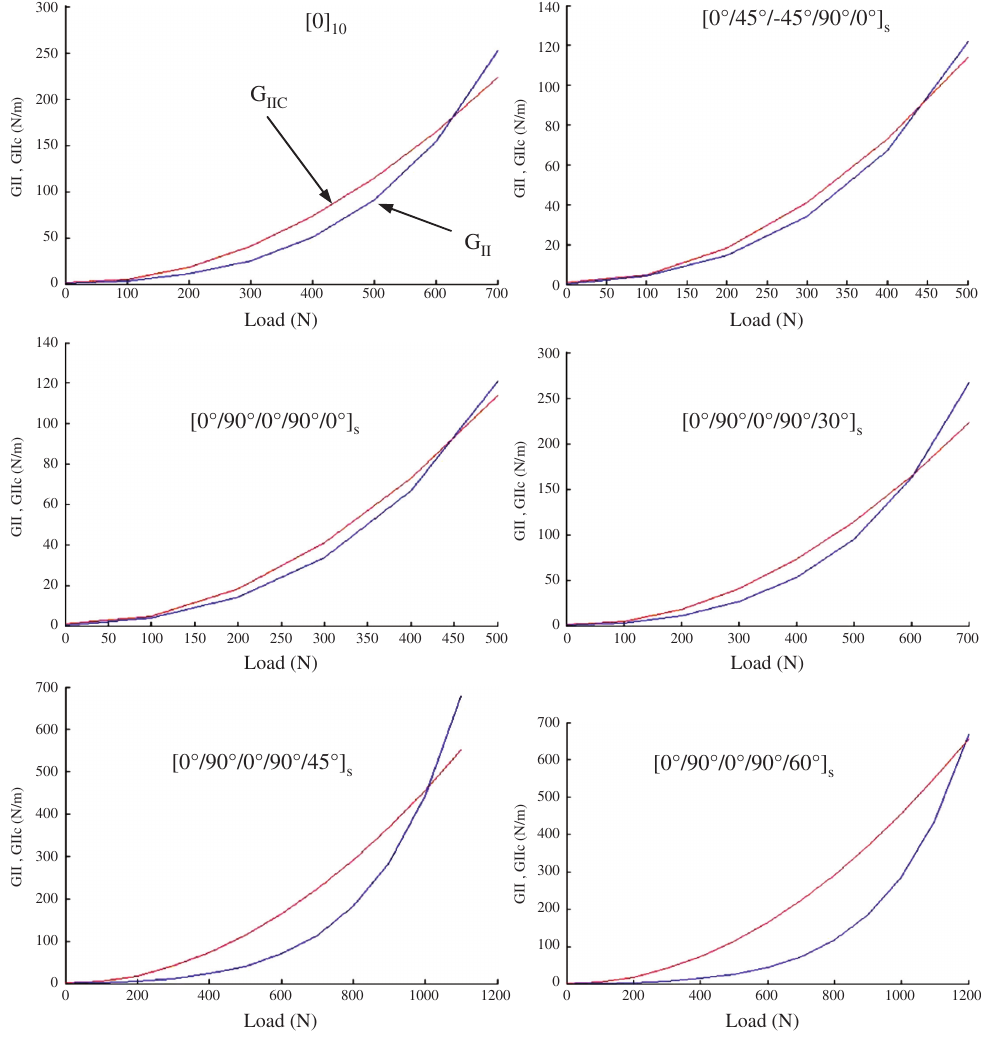
Table 1 Comparison of the meshfree method results of the carbon/ epoxy laminate (AS4/3501-6) with [0 ° ]